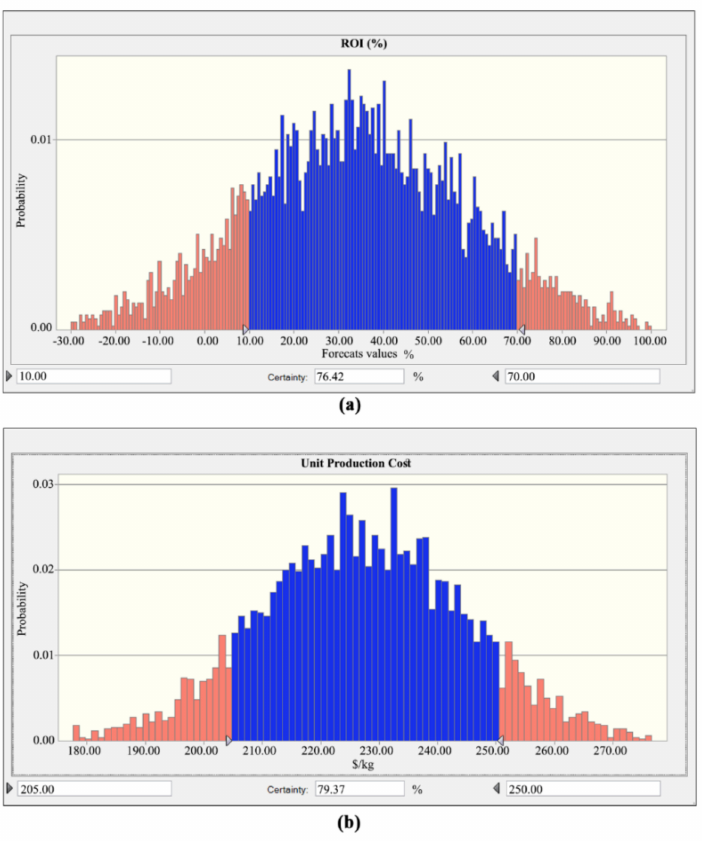
Figure 10. Probability distribution diagram after 5000 trials for ( a ) ROI and ( b ) unit production costs.